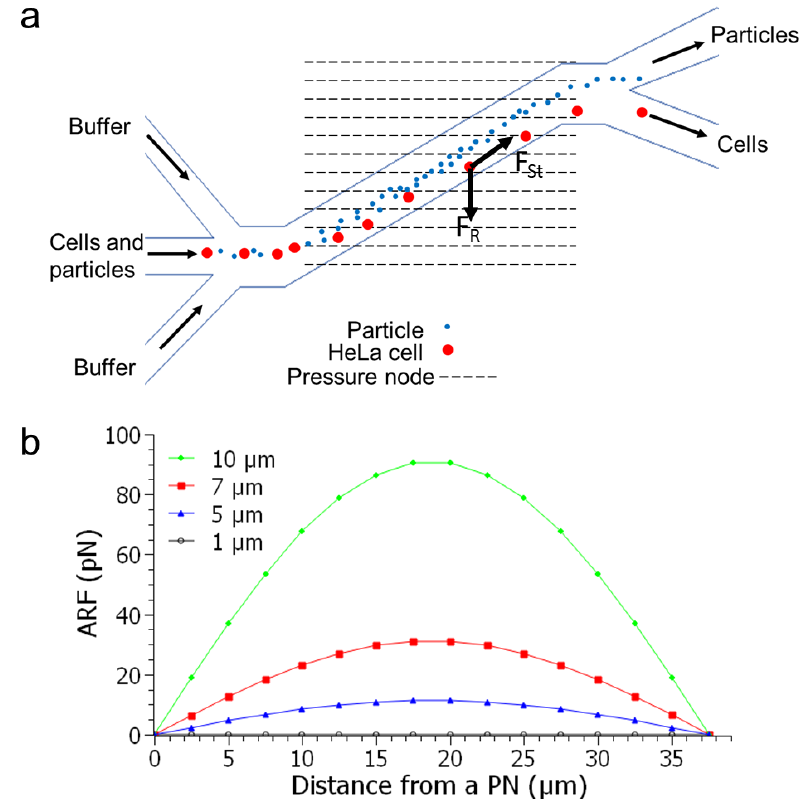
Figure 4. Working principle of the acoustic device. ( a ) A schematic depiction of the acoustic device geometry and acoustic pressure nodes. F R : Acoustic radiation force, F St : Stoke’s drag force. ( b ) Plot of the acoustic radiation force for different size polystyrene microparticles. PN: pressure node. ARF: Acoustic radiation force.